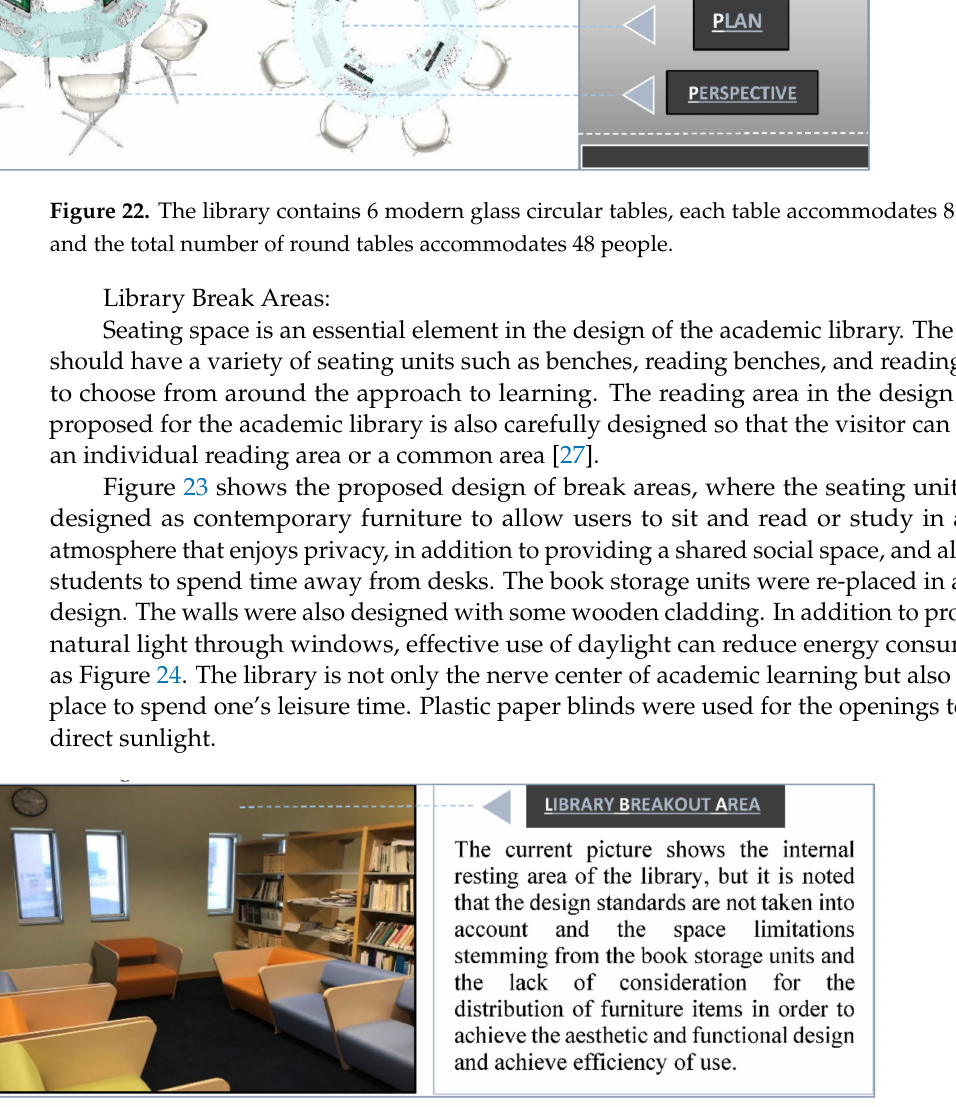
Figure 23. Shows the internal resting area of the library.